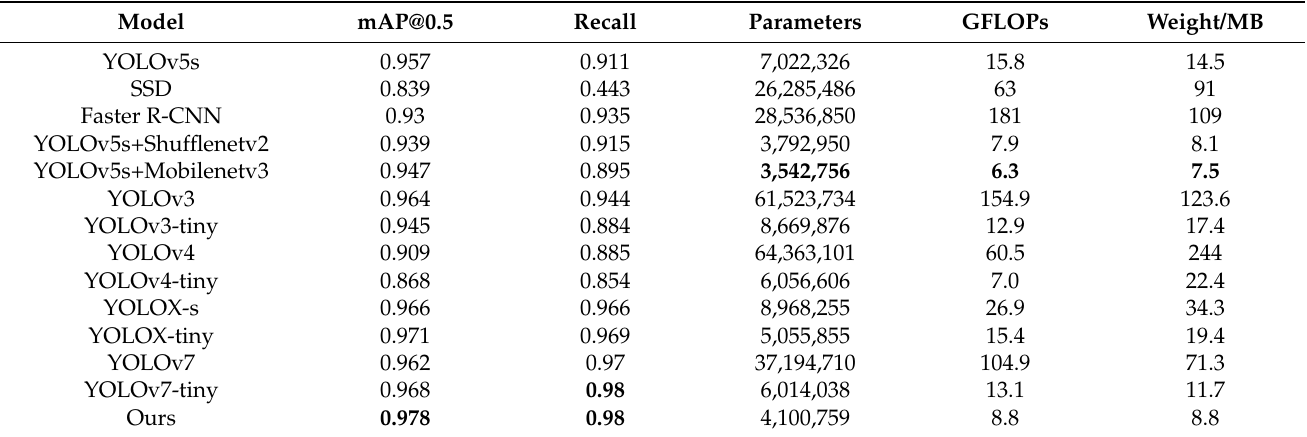
Table 5. Comparison of different lightweight models for tennis ball detection and